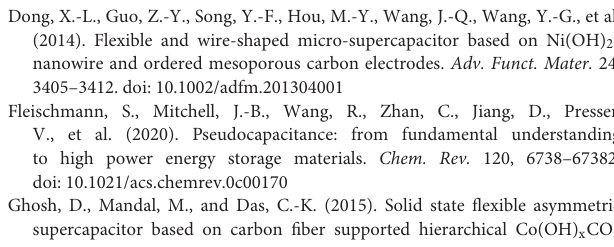
such as potential window (1.5 V), energy density (62 Wh kg −